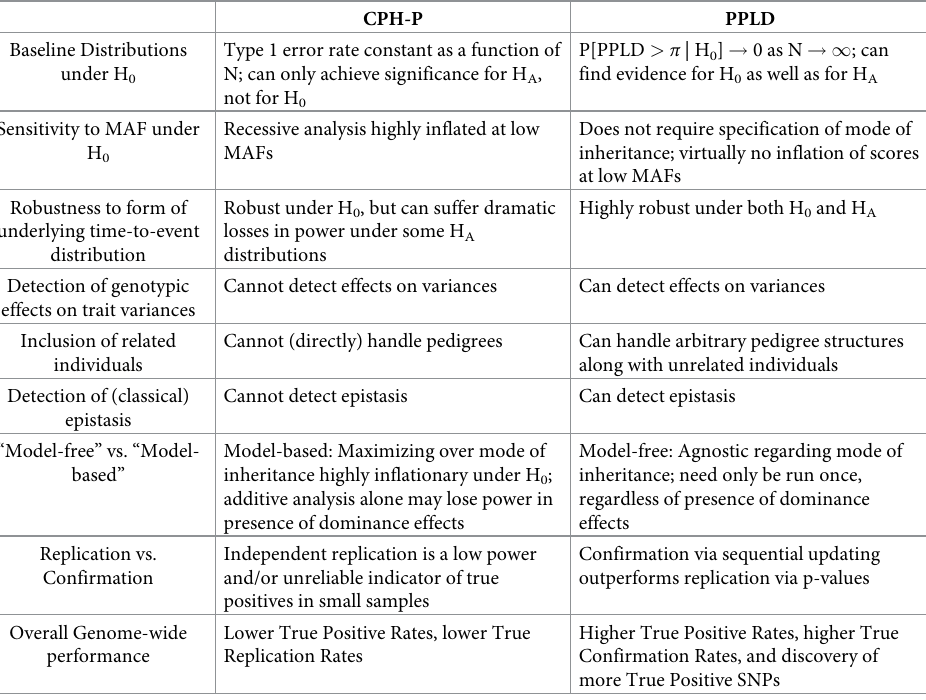
Table 13. Summary comparisons between CPH-P and the